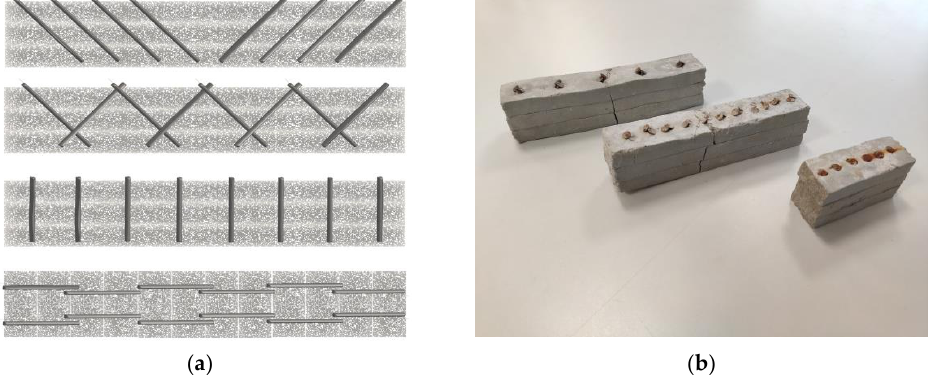
Figure 3. Manufactured samples geometries: ( a ) schematic views; ( b ) pictures of samples after bending tests.